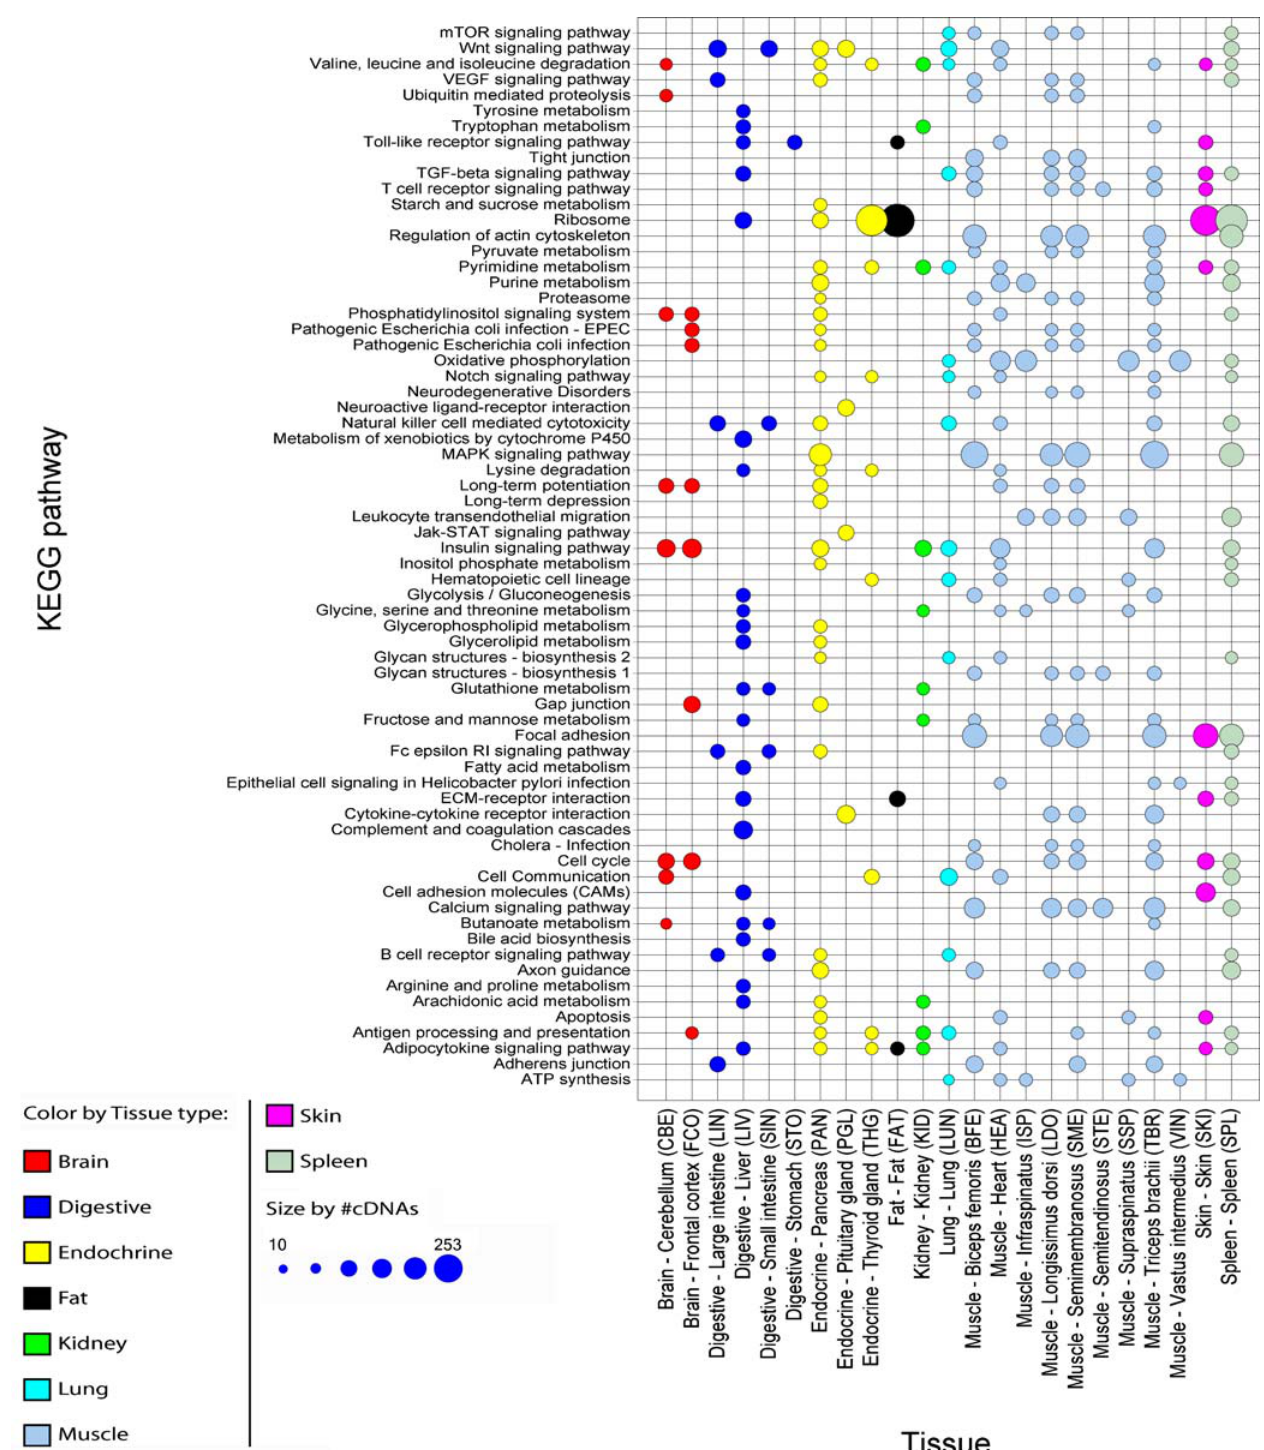
Figure 2. KEGG pathways for cDNAs representing differently expressed genes across tissues. Size of dots corresponds to the number of cDNAs (minimum=10 and maximum=253) that were tested to have a positive influence on the expression levels and color codes indicate tissue type. Only significant (P # 0.05) KEGG pathways represented by 50 or more cDNAs on the array were included. doi:10.1371/journal.pone.0001203.g002 products of the assumed genes represented by PC_206947, PC_207214, PC_207218. Signal peptides were also found in the domain prediction in the amino acid sequence translated from cDNA and genome sequences using the SMART web program amino acid sequences of PC_207214 and PC_207218. The amino [21] showed the presence of transmembrane regions in the protein acid sequence for PC_207224 was predicted to contain an